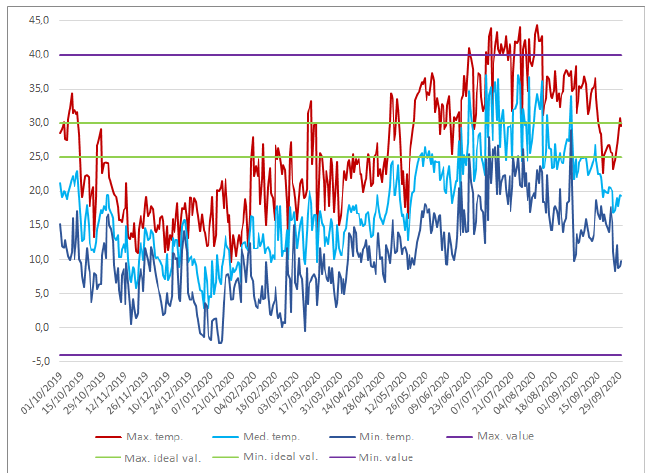
Figure 16. Temperature evolution with ideal and critical